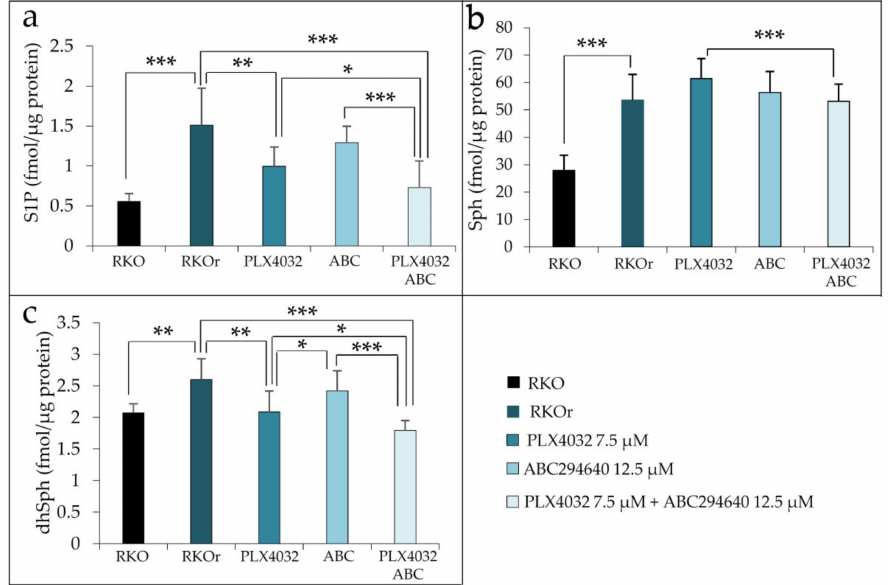
Figure 4. Sphingolipidomic analysis of different sphingolipids species using ultra high-performance liquid chromatography coupled with triple quadrupole mass spectrometry (UHPLC/MS/MS). Cells were cultured in the presence or absence of the drugs for 48 h. Results are expressed as fmol/ µ g pro- tein concentration and represent the levels of S1P ( a ), sphingosine (Sph) ( b ) and dihydrosphingosine (dhSph) ( c ). Asterisks mark statistical significance (* p < 0.05, ** p < 0.01, *** p < 0.001). Results were obtained from three individual biological experiments performed in two technical replicates. ABC (ABC294640), PLX